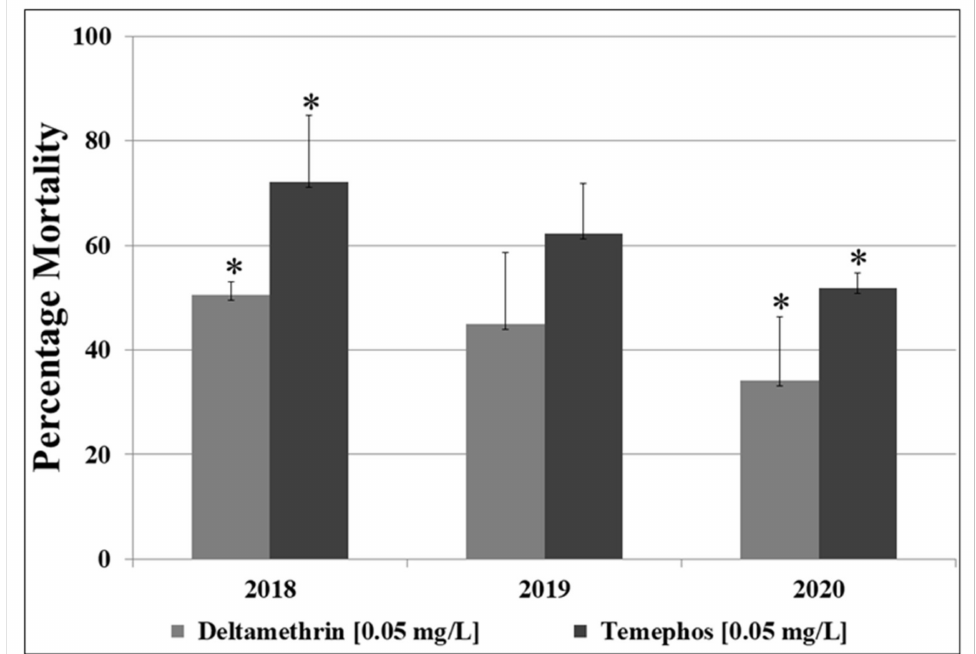
Figure 1. Results of larval bioassays with temephos and deltamethrin for 2018, 2019 and 2020 populations of Ae. aegypti, from BUK. Results are average of mortalities from four replicates for 0.05 mg/L concentration after 24 h exposure. Error bars indicate standard deviation of means. * = mortalities significantly different when comparing 2018 populations with